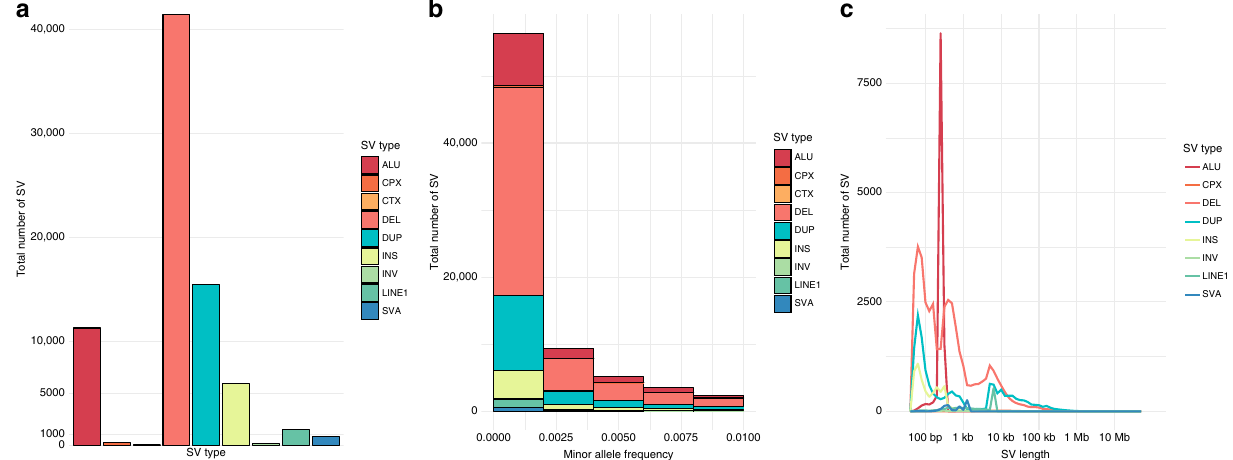
Fig. 1 Details of CMC SV dataset. Characterization of high con fi dence rare (<0.5%) SV dataset strati fi ed by a type of SV, b allele frequency, and c length (log10-scaled) colored by type of SV. SV types, include Alu (Alu), complex (CPX), translocation (CTX), deletion (DEL), duplication (DUP), insertion (INS), inversion (INV), long interspersed nuclear element-1 (LINE1), SINE-VNTR-Alu (SVA), including short interspersed nuclear elements, variable number tandem repeat, and